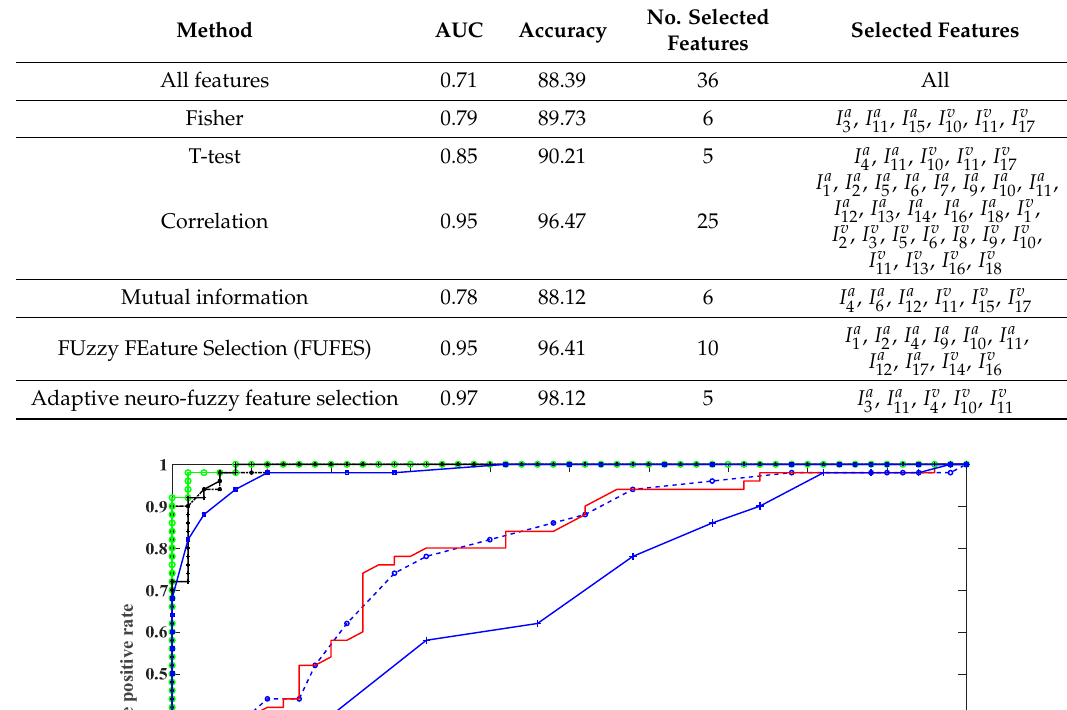
Table 5. Obtained classification accuracy and selected features for each feature selection method.